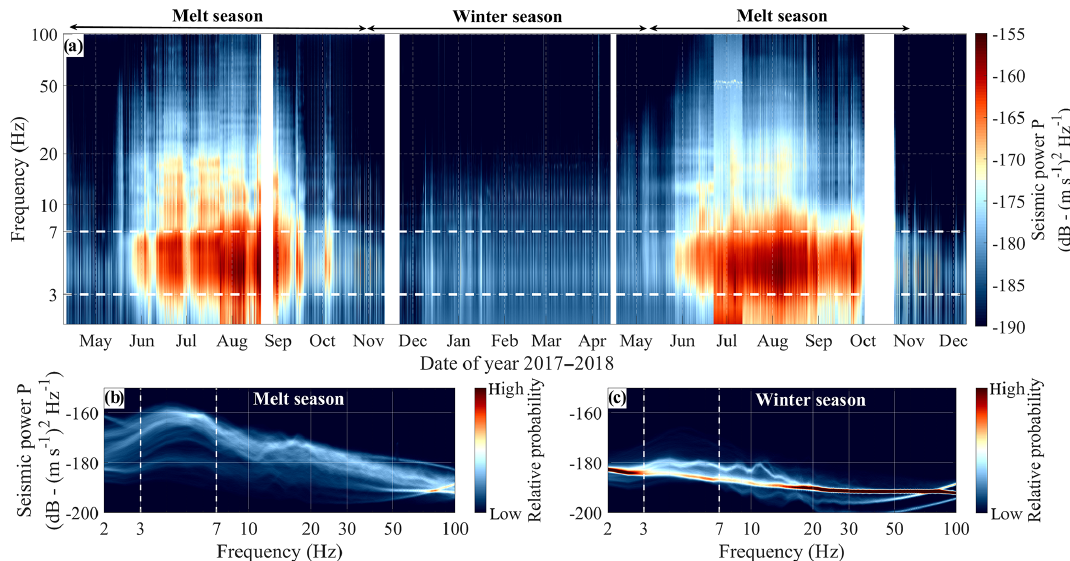
Figure 4. (a) Spectrogram of the observed seismic power P as a function of time ( x axis; May 2017 to December 2018) and frequency ( y axis; 1–100Hz log scale). Colours represent seismic power in decimal logarithmic space (dB; relative to (ms − 1 ) 2 Hz − 1 ). White bands correspond to data gaps. (b, c) Spectral distribution of seismic power during the melt seasons (b) and the winter seasons (c) . Colours represent occurrence probability, and colour bars are identical for (b) and (c)